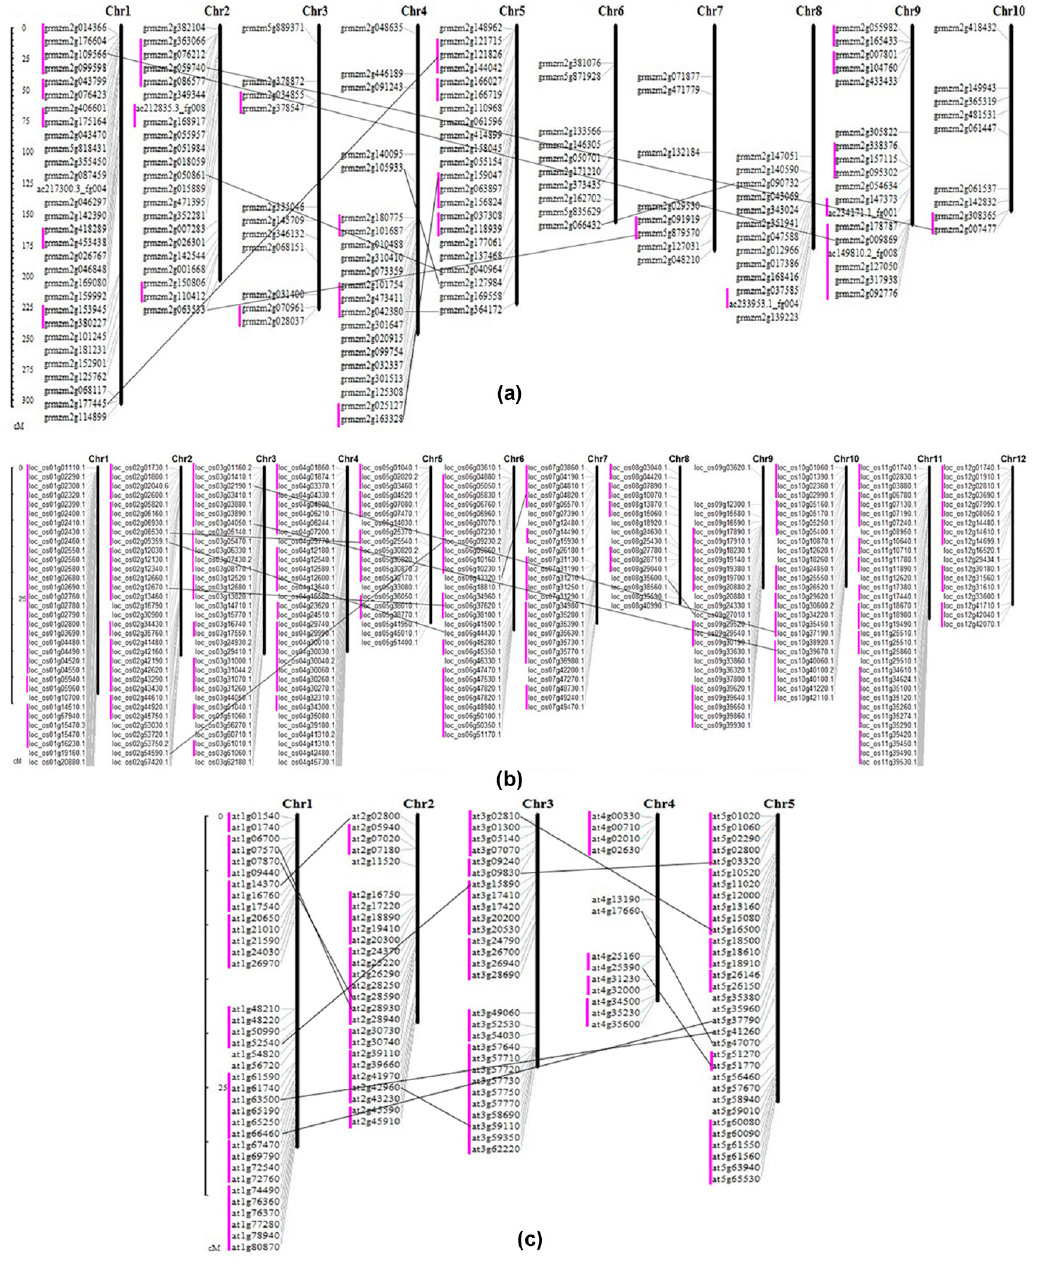
Figure 4. RLCK gene distribution on chromosomes in maize ( a ), rice ( b ), and Arabidopsis ( c ). The lines in purple represent gene clusters.